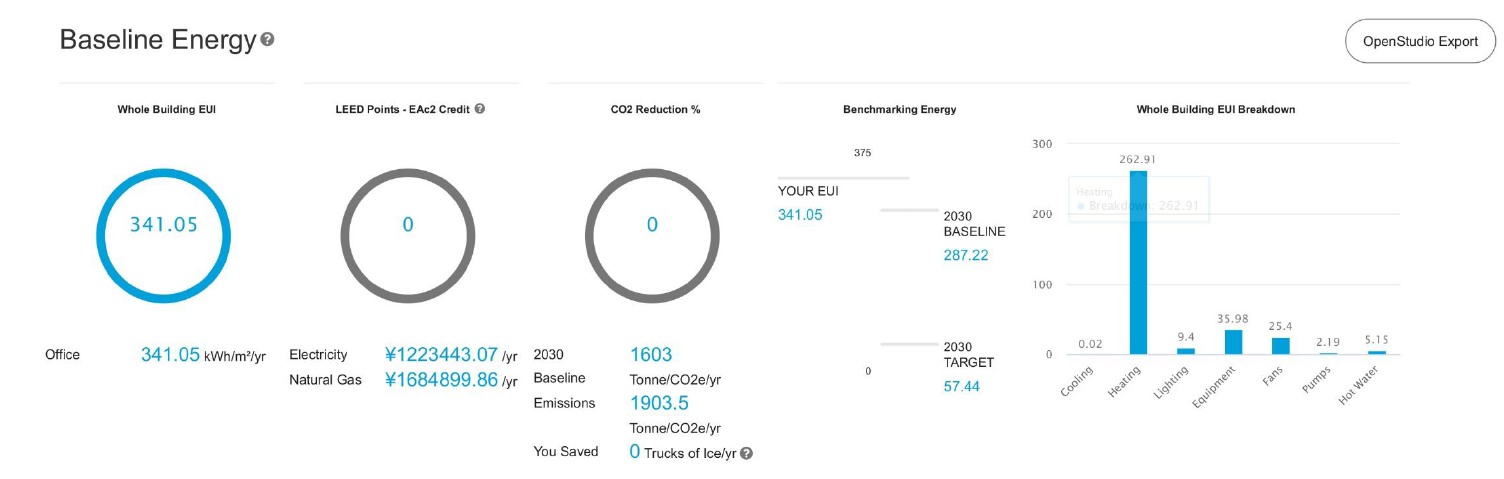
Figure A30. Zone 5-H Lhasa, Xizang (post-COVID-19 84% scenario).